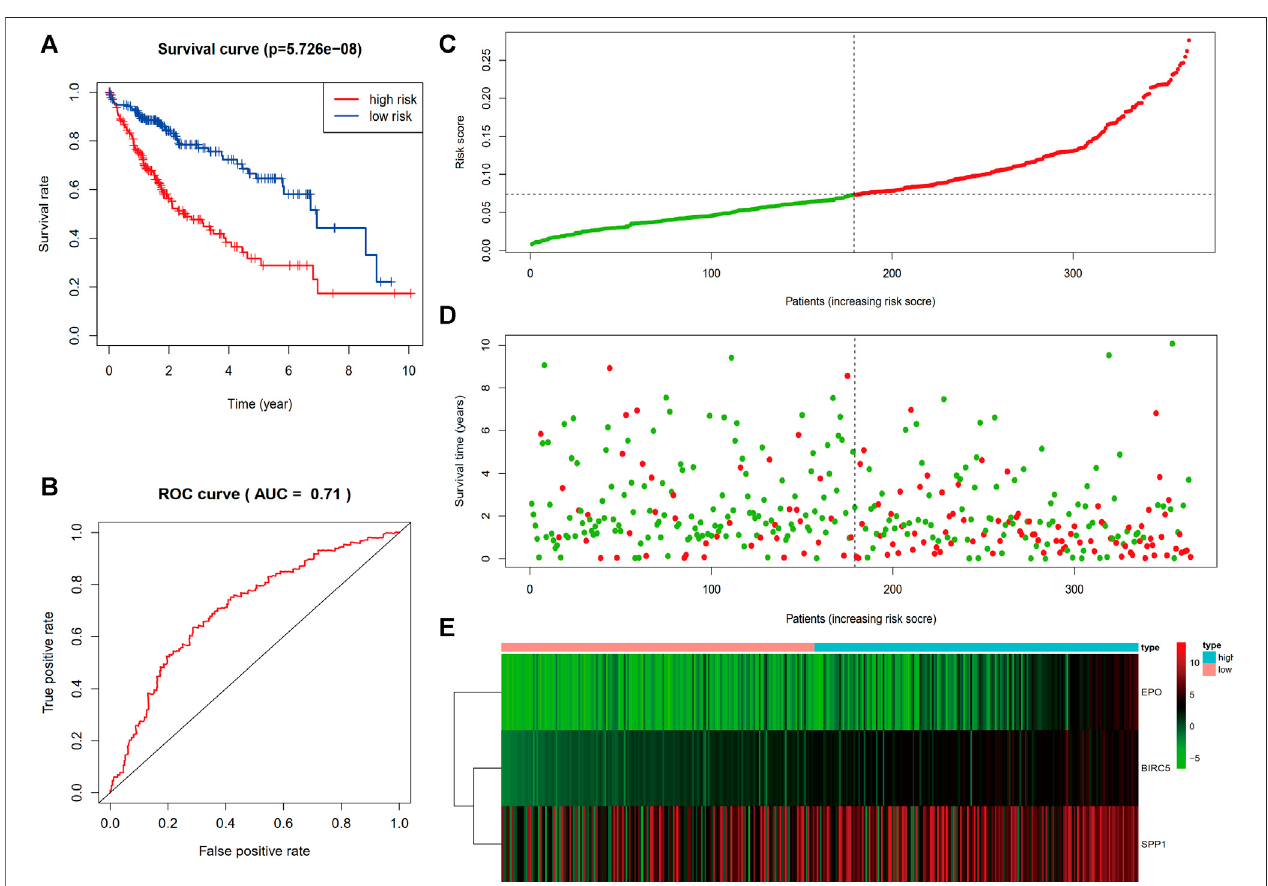
FIGURE 3 | Evaluation and validation of the prediction value of the three-gene risk signature. (A) Kaplan – Meier survival curve of the risk score. (B) ROC curve comparing the prognostic values of risk score. (C) Distribution plot of risk score. (D) Survival status of each patient. (E) Heatmap of mRNA expression levels of the three